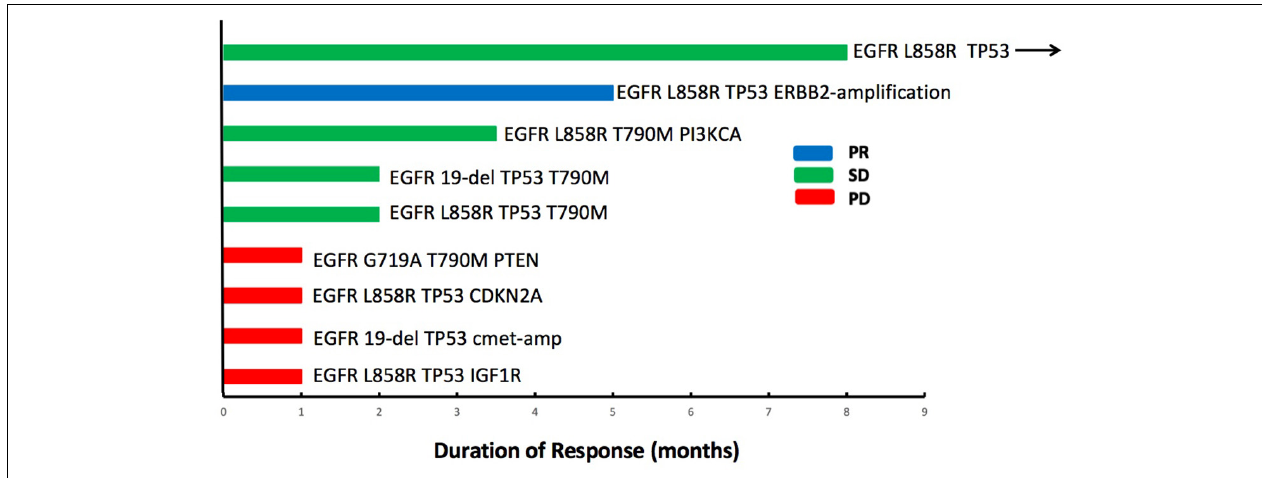
FIGURE 3 | Individual duration of combined treatment in patients with post-osimertinib/pre-combined biopsies. Patients who developed a progressive disease are denoted in red, stable disease in green, and partial response in blue. Arrows indicate patients continuing on the combination of apatinib and osimertinib at the time of last follow-up.